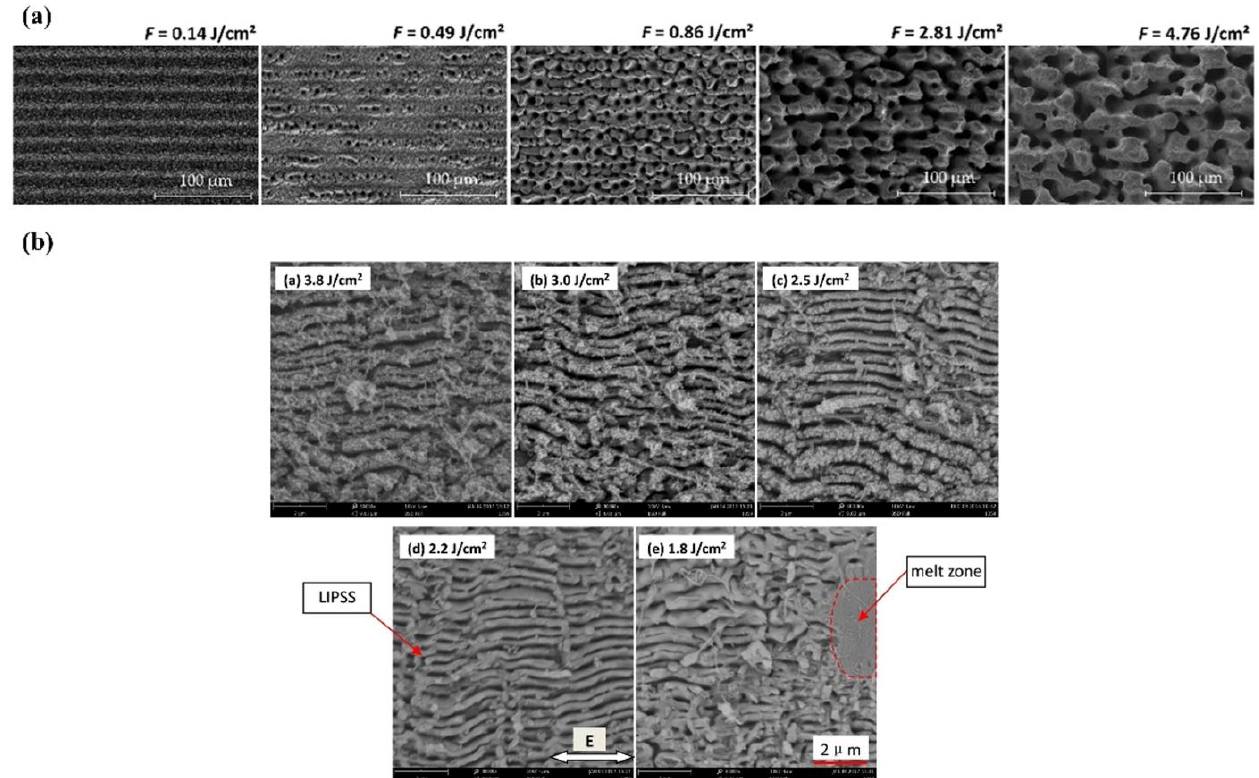
Figure 3. ( a ) Ref. [50] SEM images of structured surfaces with increasing laser fluence. ( b ) Ref. [56] Microstructures of femtosecond laser irradiation regions with different fluence.